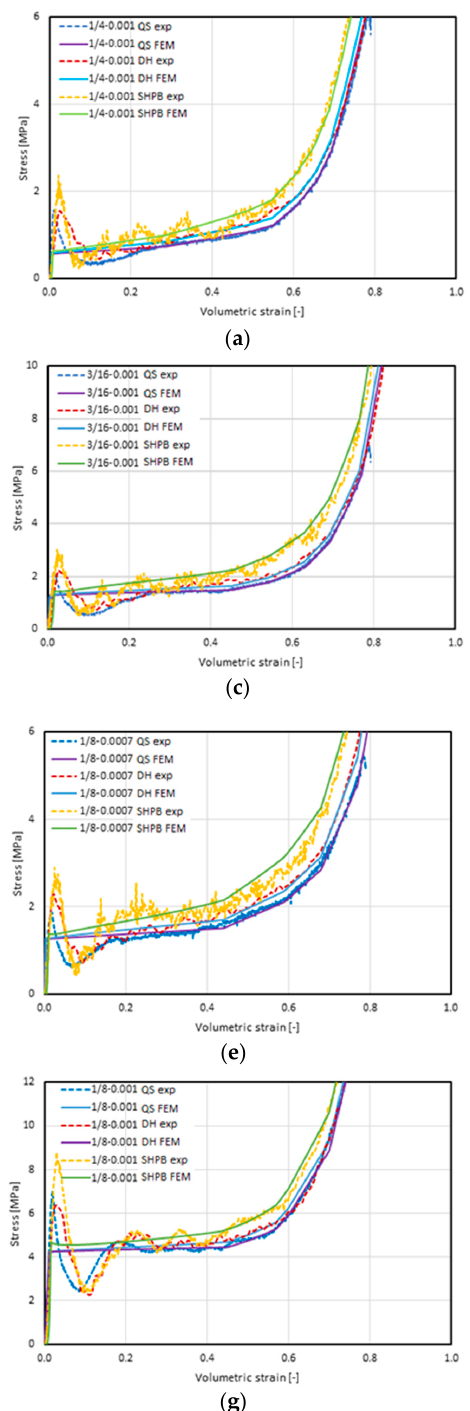
Figure 16. Summary of the stress–volumetric strain characteristics obtained using the FEM–homo- geneous model (FEM) and experimentally (exp) [21] at a quasi-static load (QS) strain rate of 8.3 × 10 − 2 1/s, at a dynamic load (DH) strain rate of 3.8 × 10 2 1/s, and using a Split Hopkinson Pressure Bar (SHPB) with a strain rate of 3.3 × 10 3 1/s) of the materials, including ( a ) 1/4-5052-0.001; ( b ) 3/16-5052- 0.0007; ( c ) 3/16-5052-0.001; ( d ) 3/16-5052-0.0015; ( e ) 1/8-5052-0.0007; ( f ) 1/8-5052-0.001; and ( g ) 1/8- 5052-0.0015.